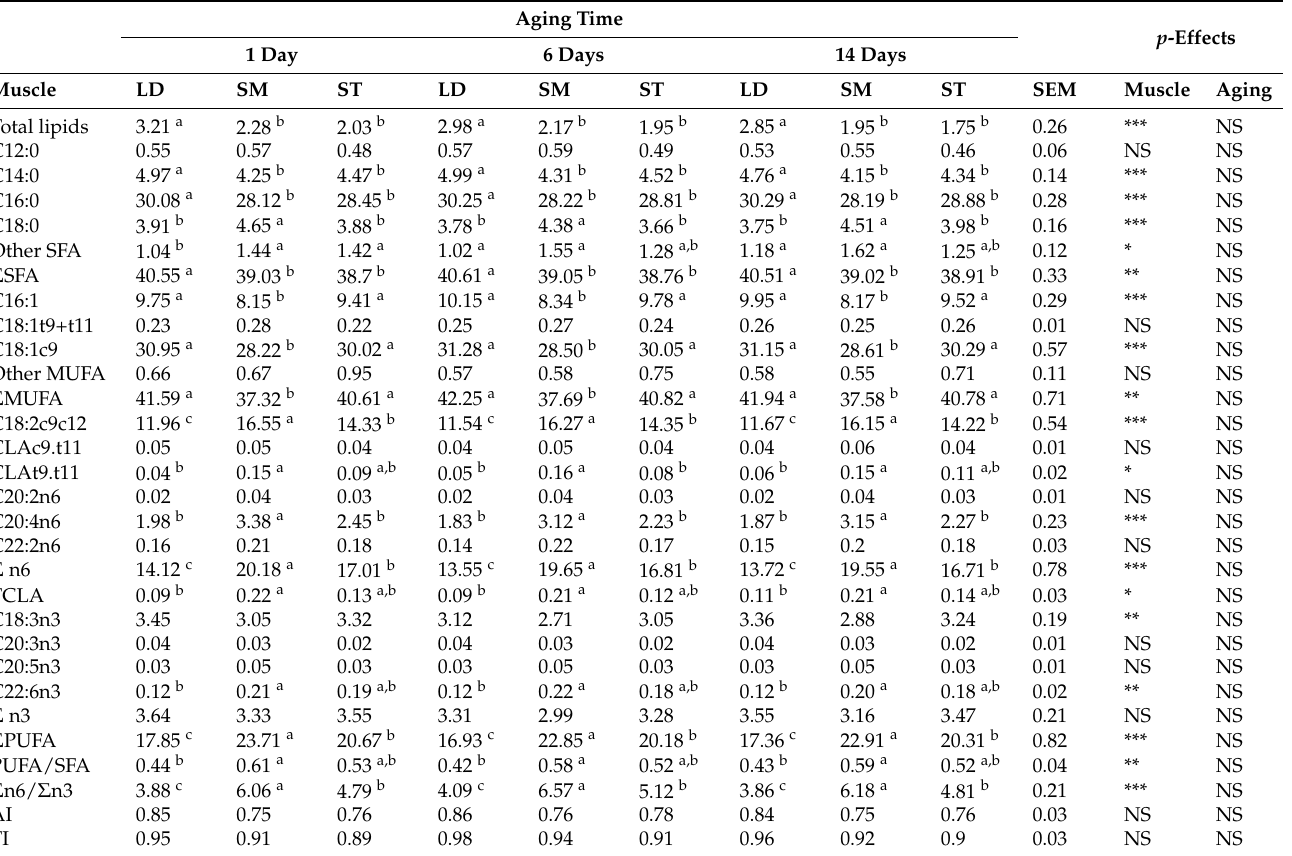
Table 1. Effect of muscle and aging time (days) on total lipids, fatty acid profile (g/100 g fatty acids), and health lipid indices of meat from horse (means ±